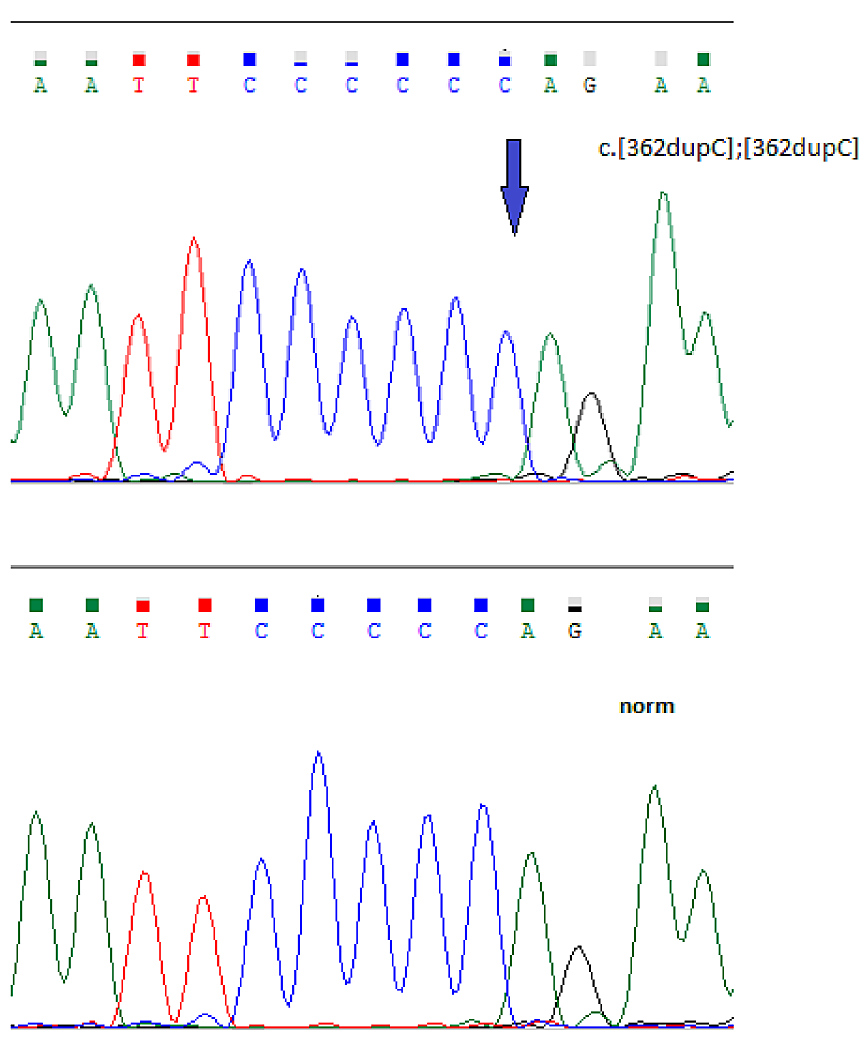
Figure 3. A homozygous c.362dupC pathogenic variant in exon 3 of the FKBP14